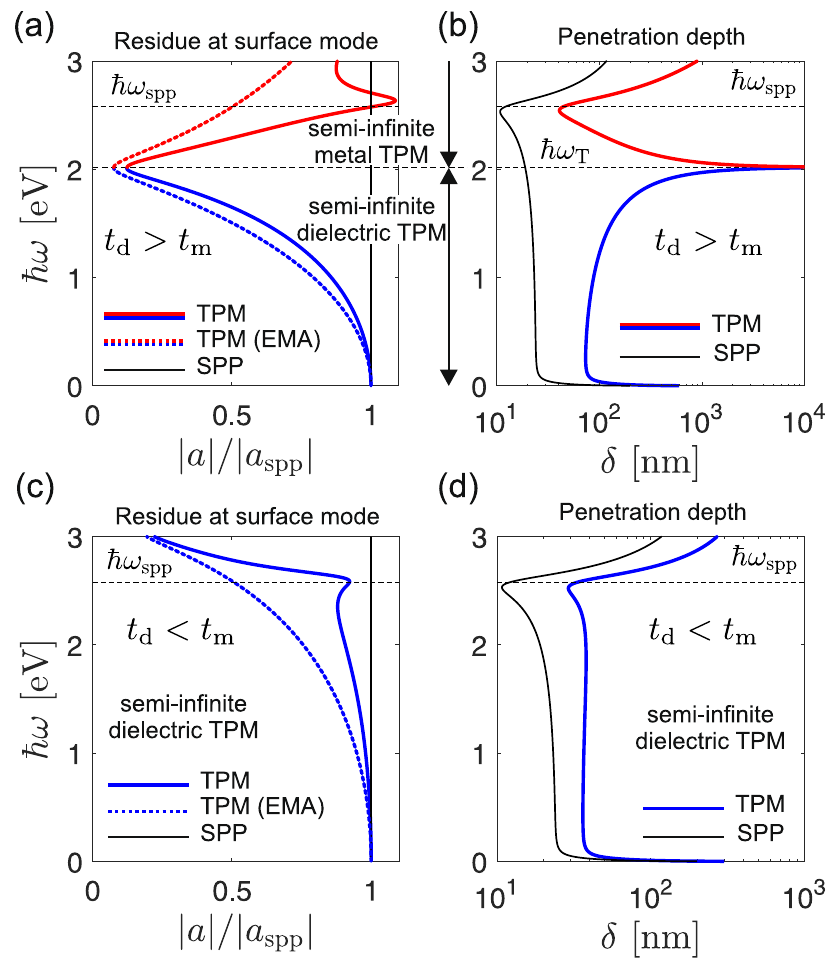
Figure 5. Left panels: residue at the TPM and SPP mode, drawn for the ( a ) t d > t m and ( c ) t d < t m examples, respectively. Righ panels: penetration depths into the superlattice for ( a ) t d > t m and ( c ) t d < t m examples, compared with the corresponding SPP penetration